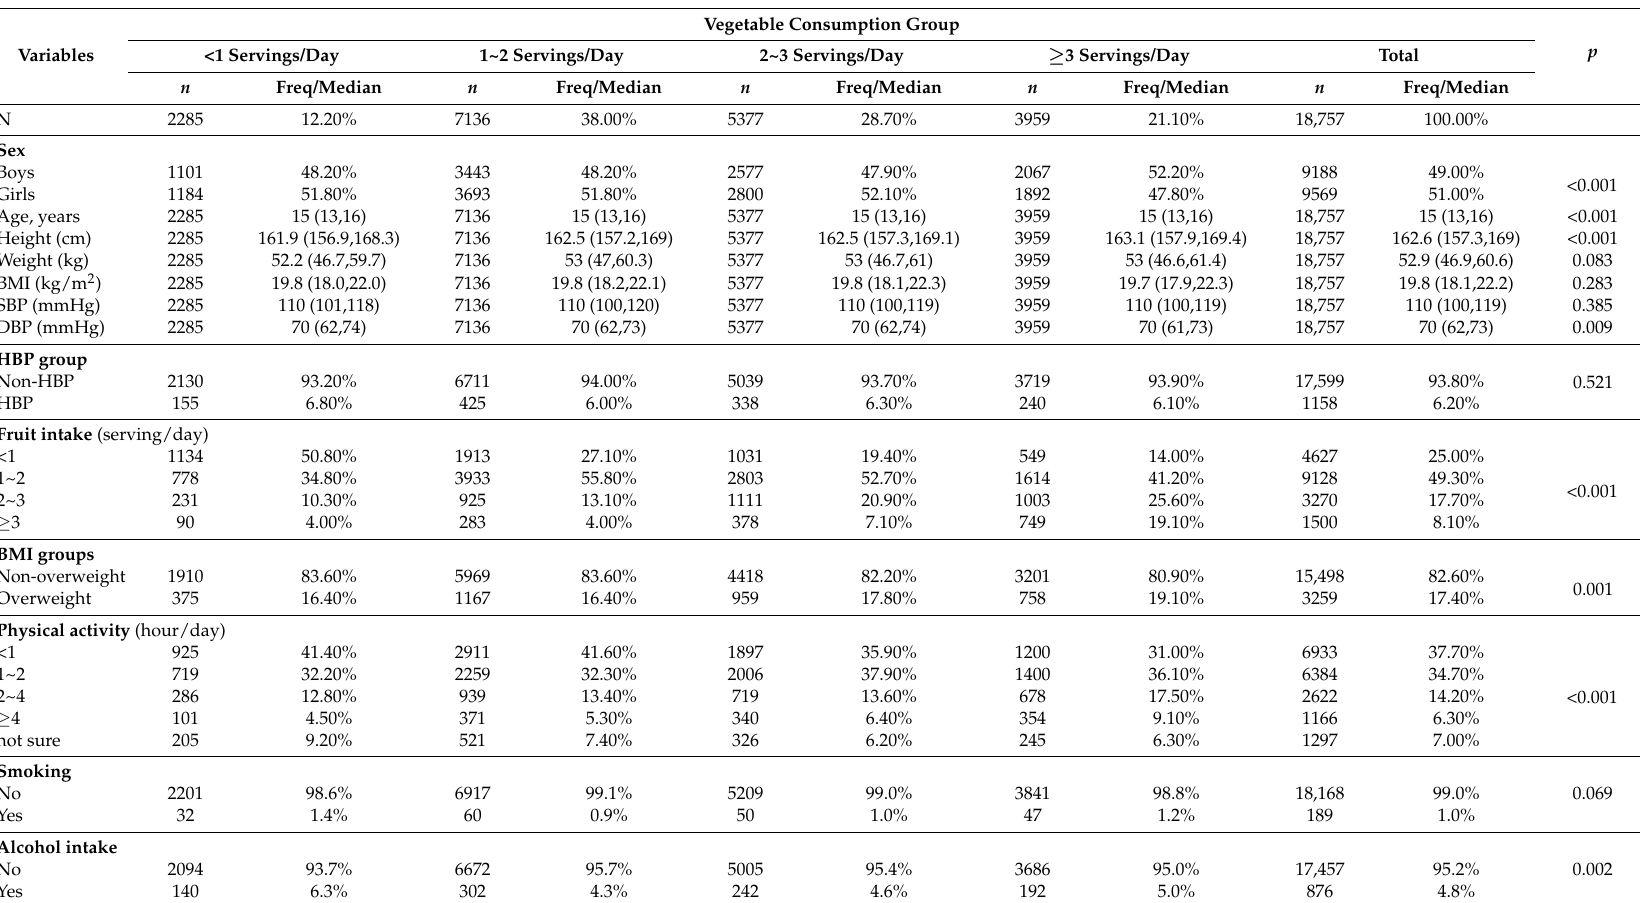
Table 1. The characteristics of the Chinese adolescents according to vegetable